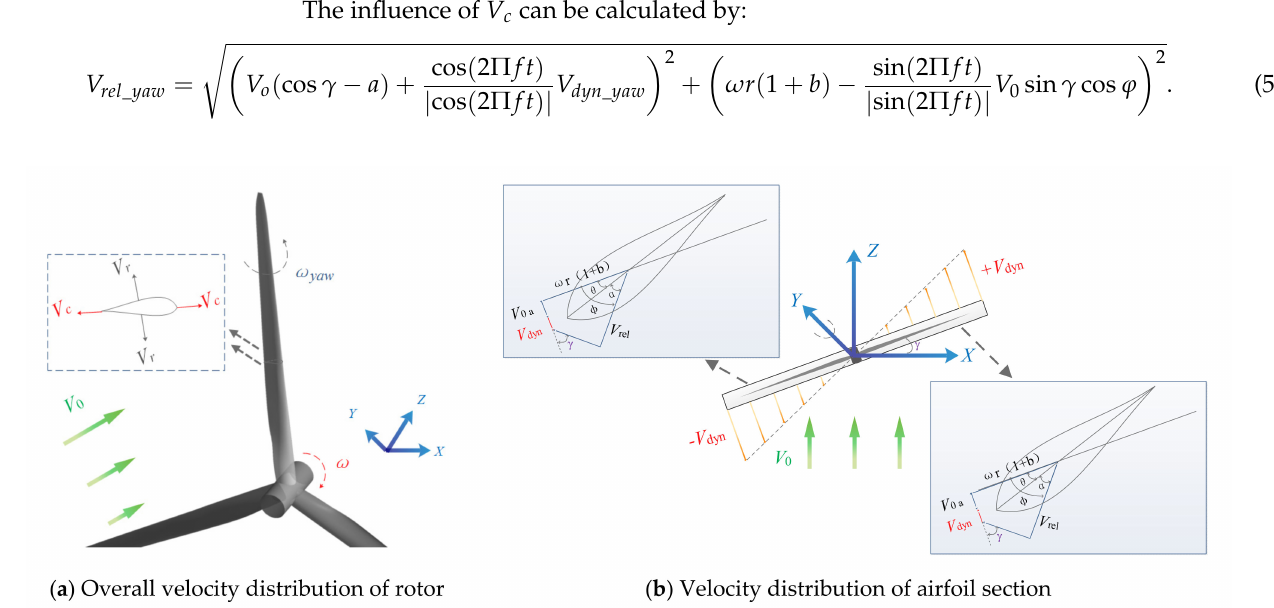
Figure 10. Velocity diagram under yaw motion.